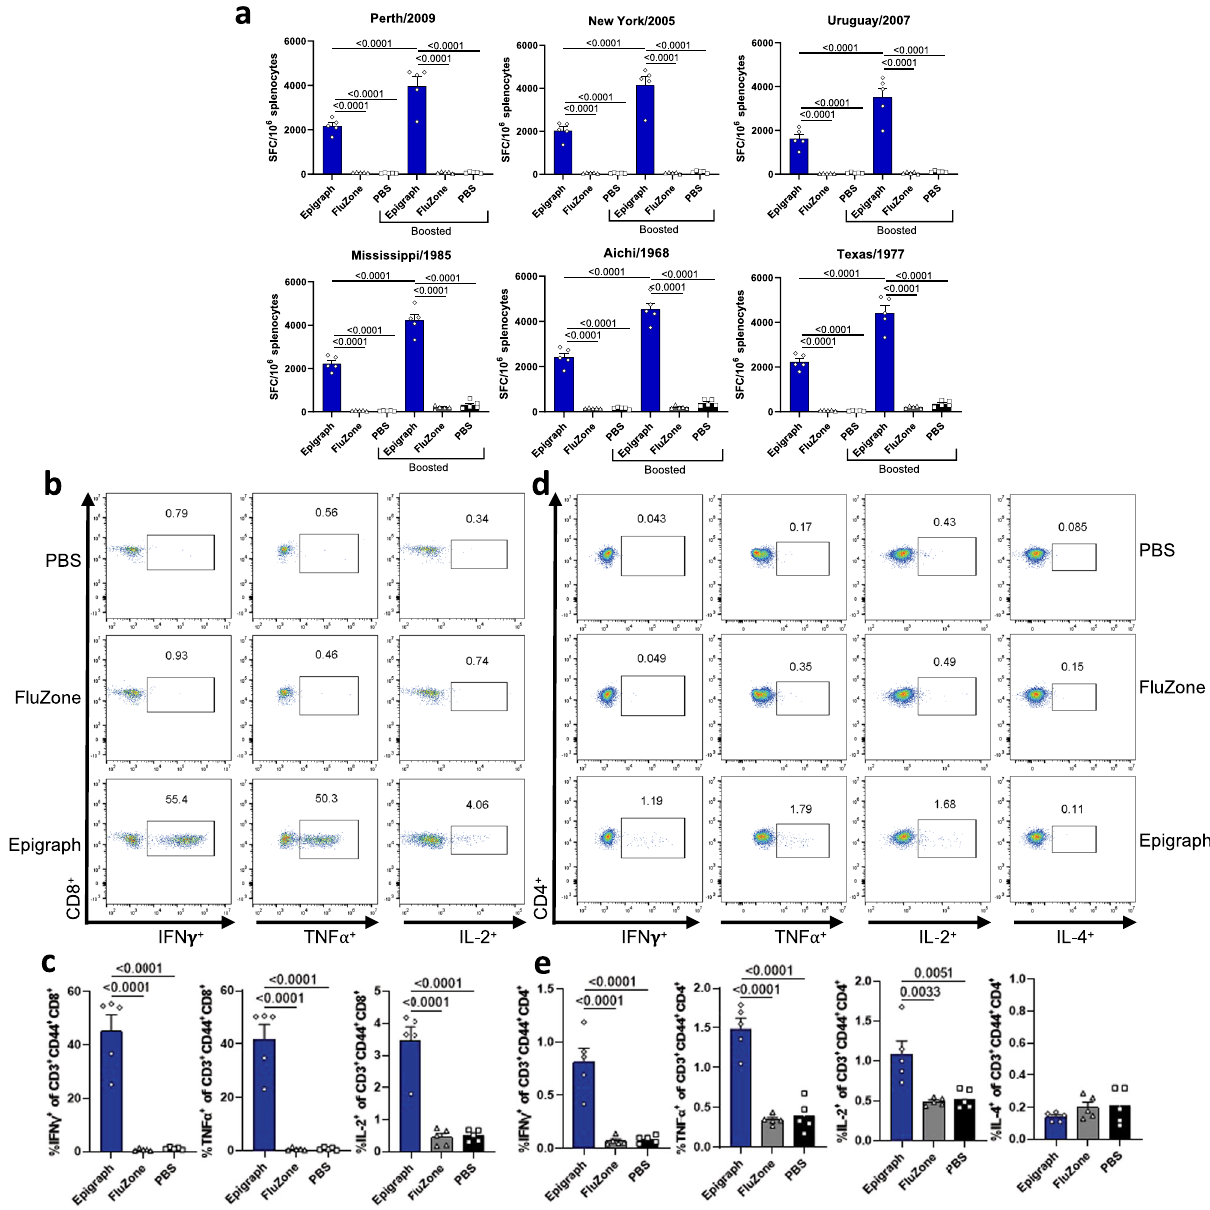
Fig. 3 Epigraph immunization induces cross-reactive T-cell responses in mice against 6 diverse H3 viruses. a The total T-cell response after vaccination of BALB/c mice ( n = 5) was determined using an interferon IFN- γ ELISpot with peptide libraries for six H3 strains. T-cell responses are reported as spot-forming cells (SFC) per million splenocytes ( n = 5; one-way ANOVA with Tukey multiple comparisons). Cytokine pro fi les were determined using ICS and fl ow cytometry on splenocytes from vaccinated BALB/c mice ( n = 5) harvested 2 weeks after boosting and stimulated ex vivo with pooled Perth/2009 peptides ( b – e ). Splenocytes were gated on CD3 + , CD44 high , and then CD8 + ( b , c ) or CD4 + ( d , e ) to determine HA-speci fi c T EM cells. Representative FACS plots for cytokine production for CD8 + ( b ) and CD4 + ( d ). Levels of cytokine-producing CD8 + ( c ) and CD4 + ( e ) ( n = 5; one-way ANOVA with Tukey multiple comparisons). Data are expressed as the mean with standard error